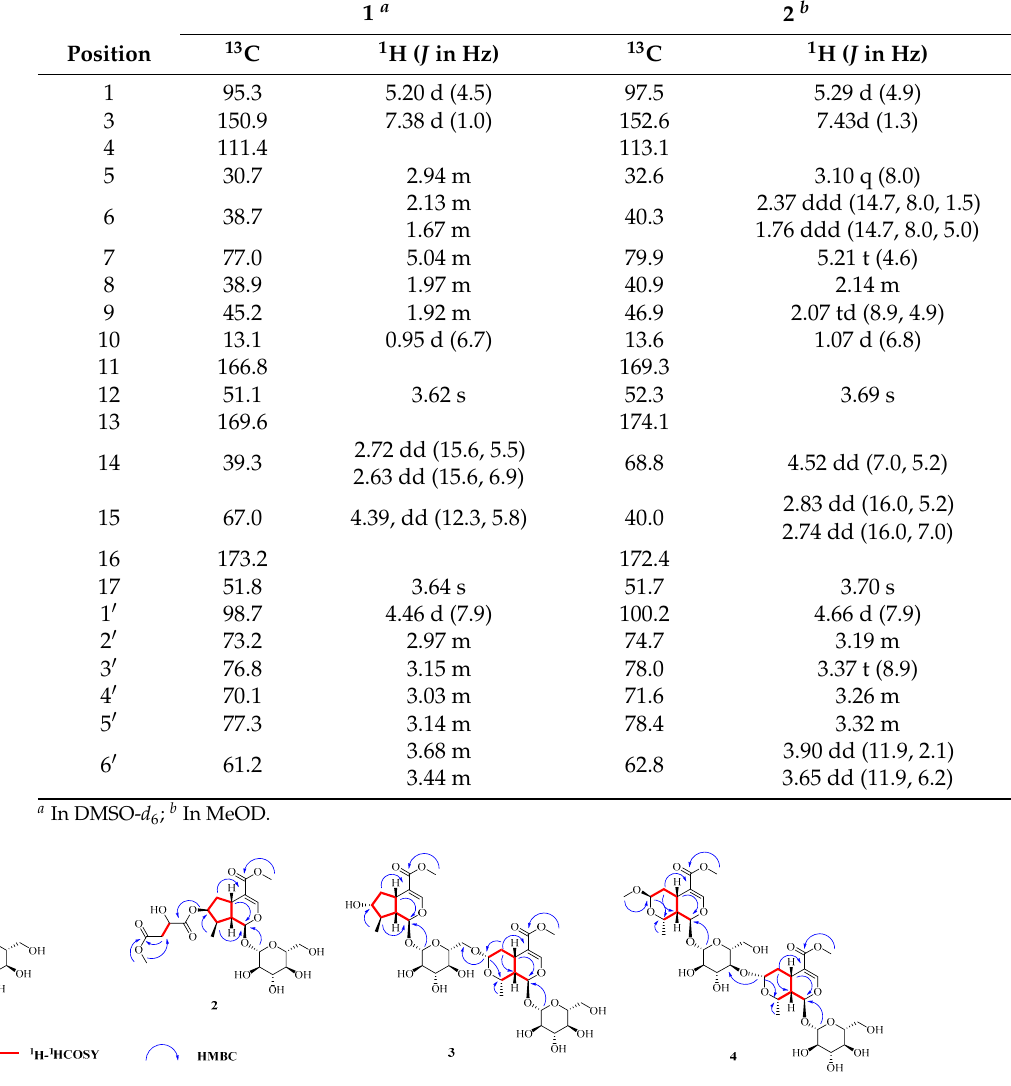
Table 1. 1 H NMR (500 MHz) and 13 C NMR (125 MHz) data ( δ in ppm, J in Hz) for compounds 1 – 2.